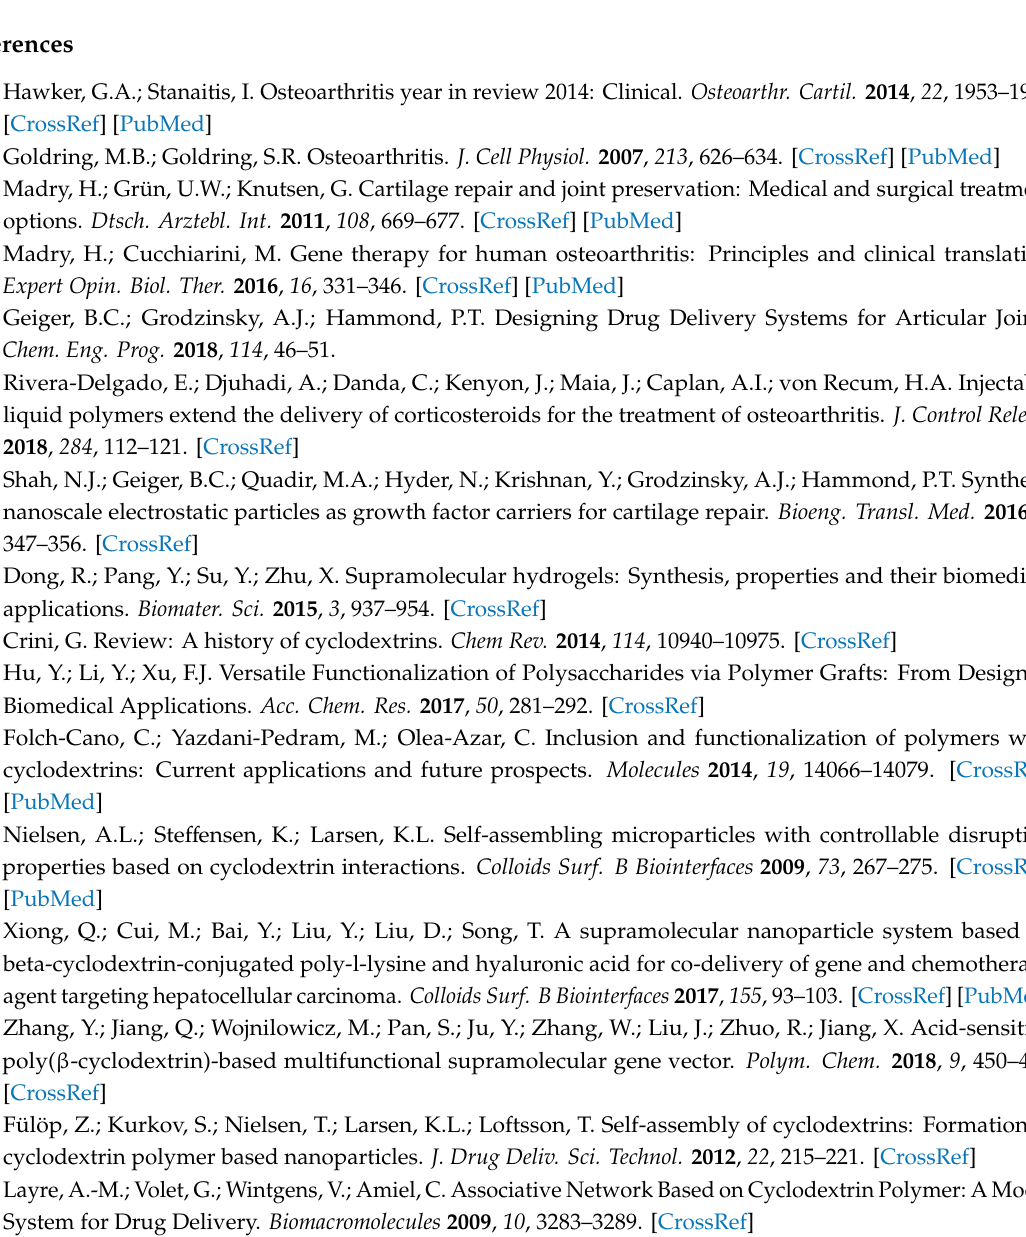
Figure S1: Lambert-Beer of free Ada-Rhod in DCM; Figure S2: Lambert-Beer of free DCF in ultrapure water and PBS; Figure S3: Size (or D H ) distribution of PolyCD (black line) and PolyCD@Ada-Rhod / DCF; Figure S4: UV / Vis of free DCF and PolyCD / DCF in ultrapure water obtained by solvent evaporation technique; Figure S5: Stability studies of PolyCD@Ada-Rhod / DCF in NaCl wt. 0.9%; Figure S6: Stability studies of PolyCD@Ada-Rhod / DCF in